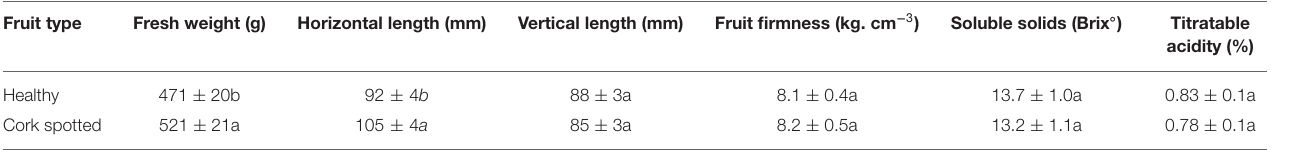
TABLE 2 | Comparison of fruit quality between healthy and cork spotted “Akizuki” fruit. Fruit